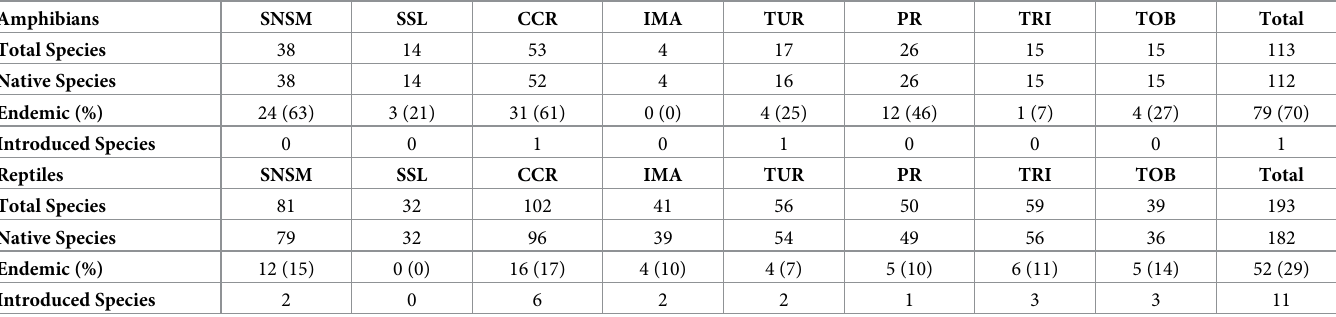
Table 1. Total number of native species, endemic and introduced amphibians (top) and reptiles (bottom) in the studied region. Amphibians SNSM